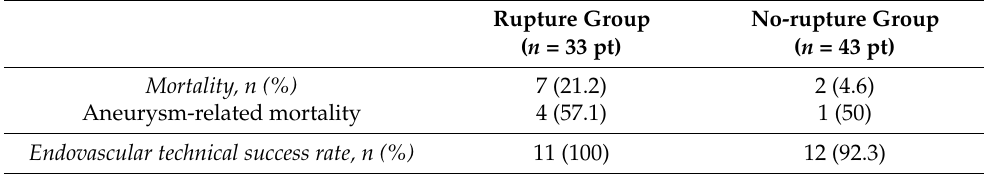
Table 5. Mortality and technical success rate after EVT of JA and IA